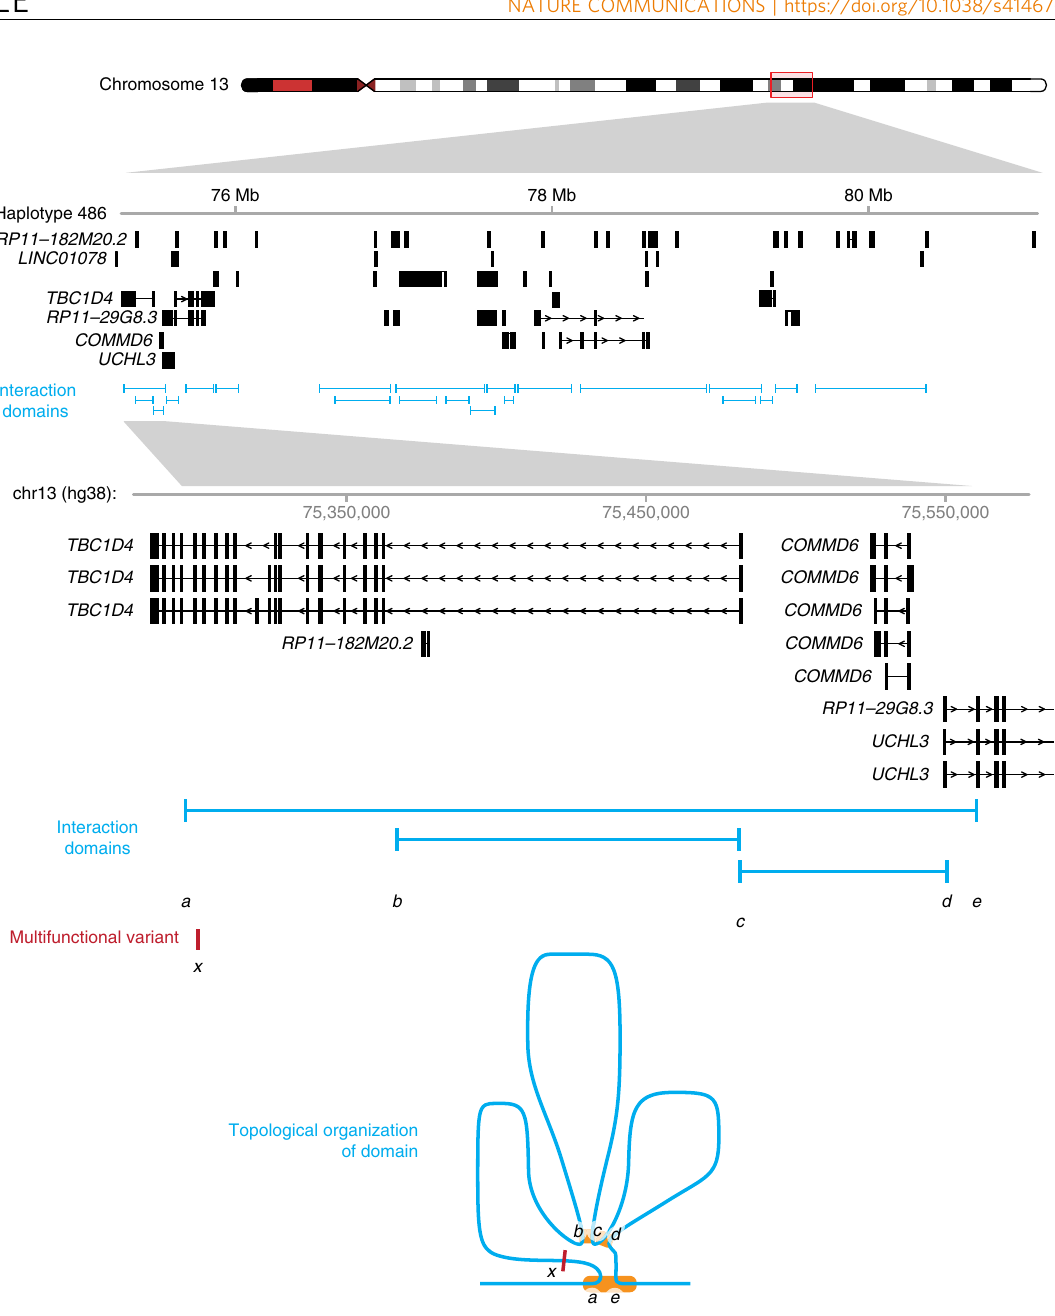
Fig. 2 Overview of the TBC1D4 haplotype. The TBC1D4 gene is at the centromeric end of an ~6 Mb haplotype on chromosome 13q. The genes and three- dimensional interaction domains are depicted, with the lower part of the panel showing the detail in the immediate TBC1D4 region. Three promoters are located within the major loop containing TBC1D4 . We show how the promoters and the multifunctional variant are predicted to be organized in three dimensions in vivo, revealing a relative proximity of the multifunctional variant (x) to the TBC1D4 (c) and UCHL3 (d) promoters, despite the multifunctional variant being 182 kb centromeric to the TBC1D4 promoter. Source data of the interaction domains are provided in a Source Data fi